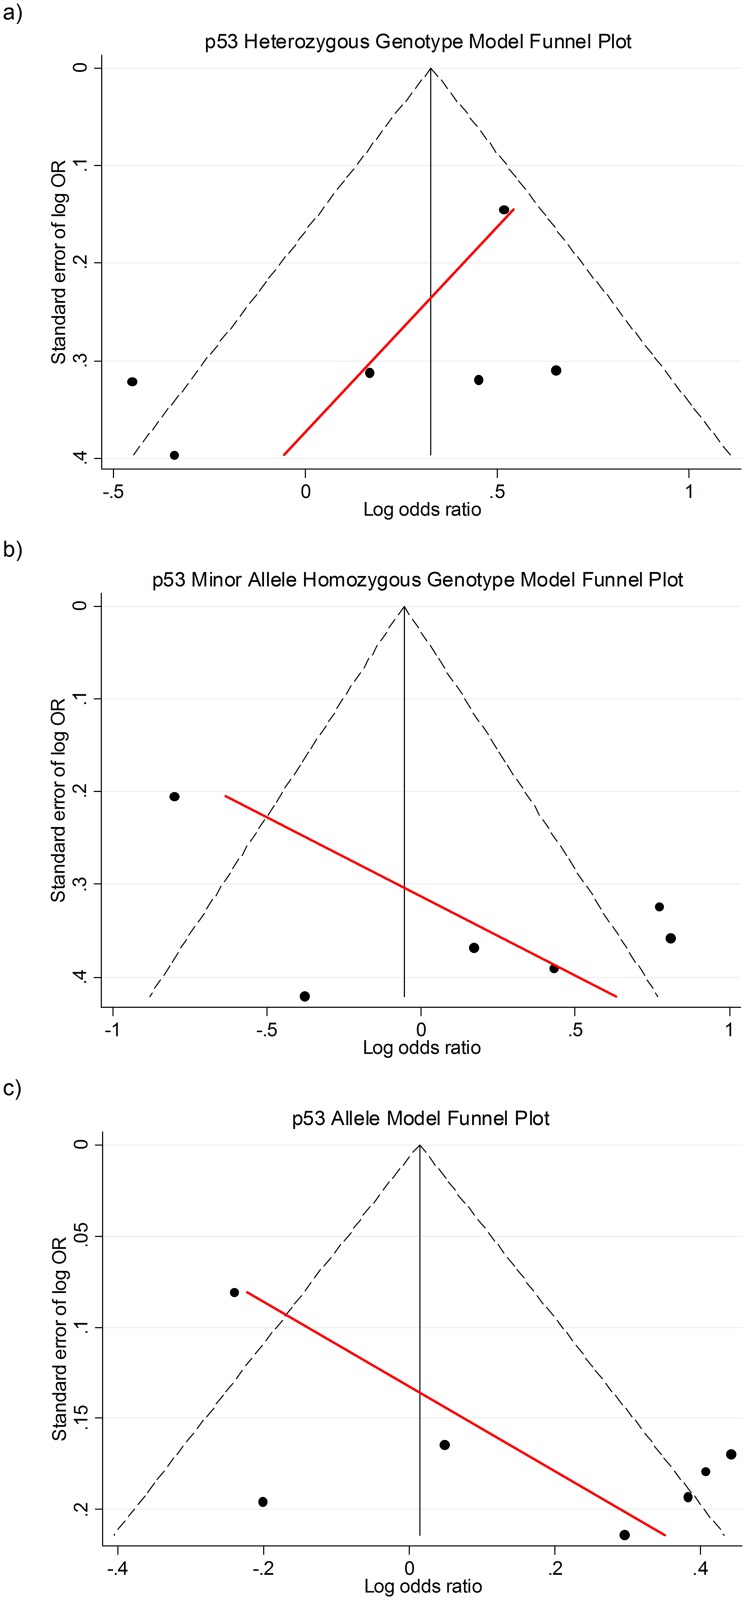
Egger test for p53 rs1042522 polymorphism a) heterozygous, b) minor allele homozygous and c) allele models.The red solid line in each funnel-plot represents the 95% confidence limits around the summary polymorphism effect.